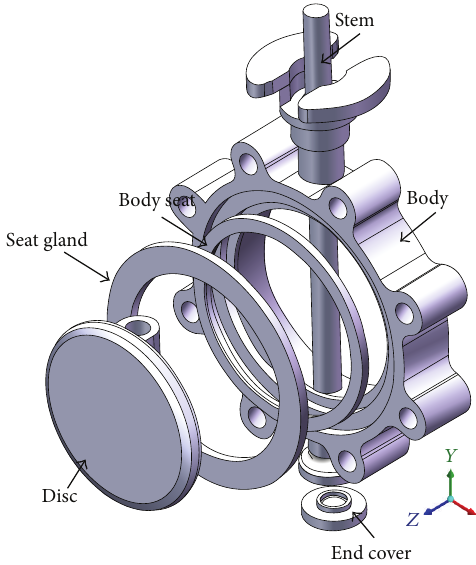
Figure 1: Configuration of a 200A butterfly